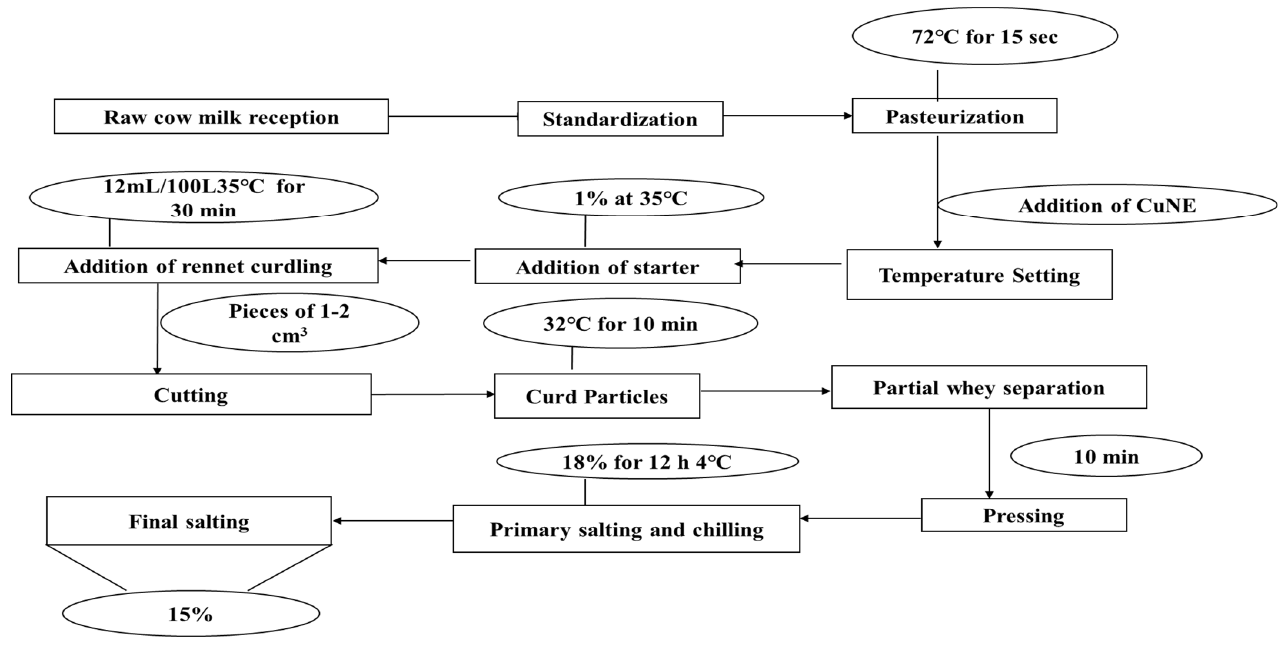
Figure 9. Schematic diagram for addition of curcumin nanoemulsion during cheese making.